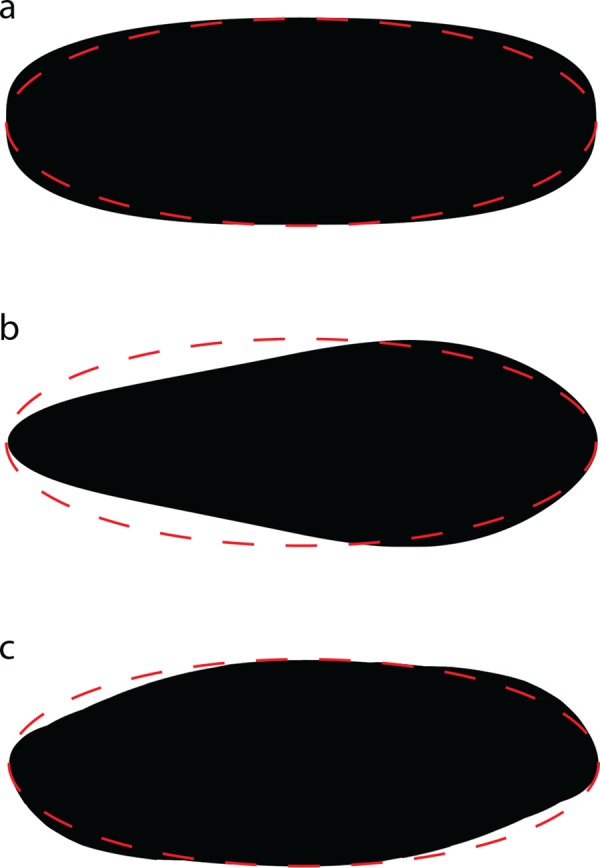
Examples of cell cross sections with different coefficient of unellipticity (U).(a) U > 1, (b) U < 1, (c) U = 1. Solid black silhouettes: cell cross sections; red dashed lines: regular ellipses having the same length and width as the cell cross section.